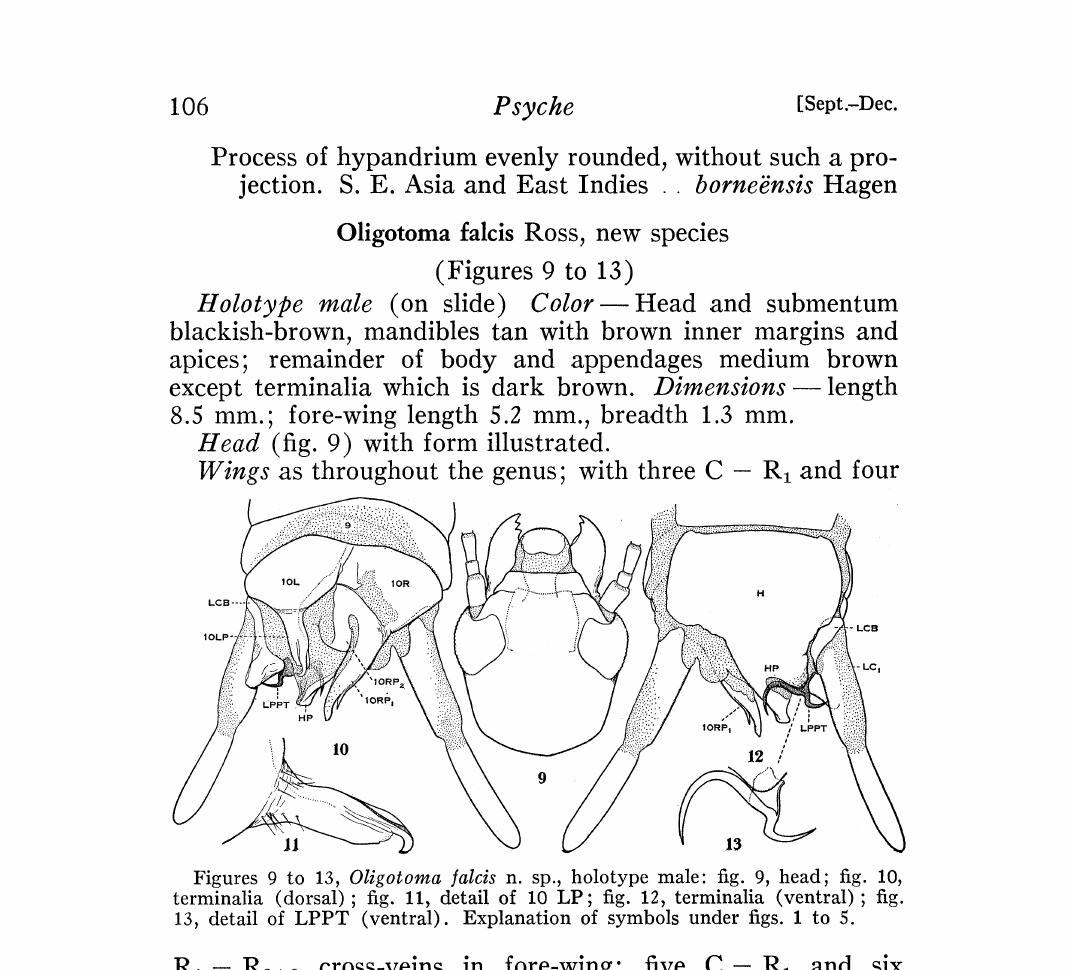
Figures 9 to 13, Oligotoma Jalcis n. sp., holotype male: fig. 9, head; fig. 10, terminalia (dorsal); fig. 11, detail of 10 LP; fig. 12, terminalia (ventral); fig. 13, detail of LPPT (ventral). Explanation of symbols under figs. to